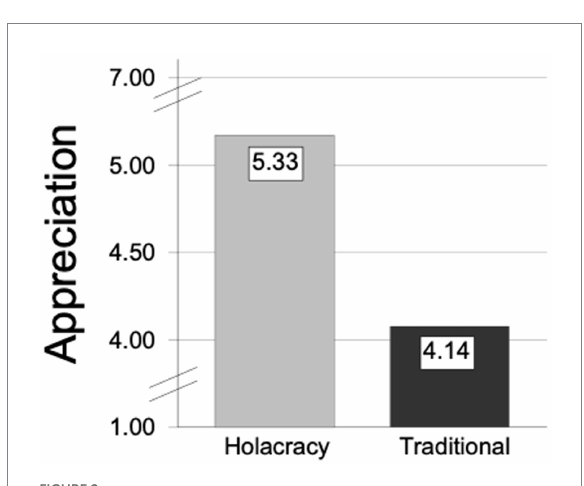
FIGURE 2 Main values of appreciation in holacratic organisations and traditional